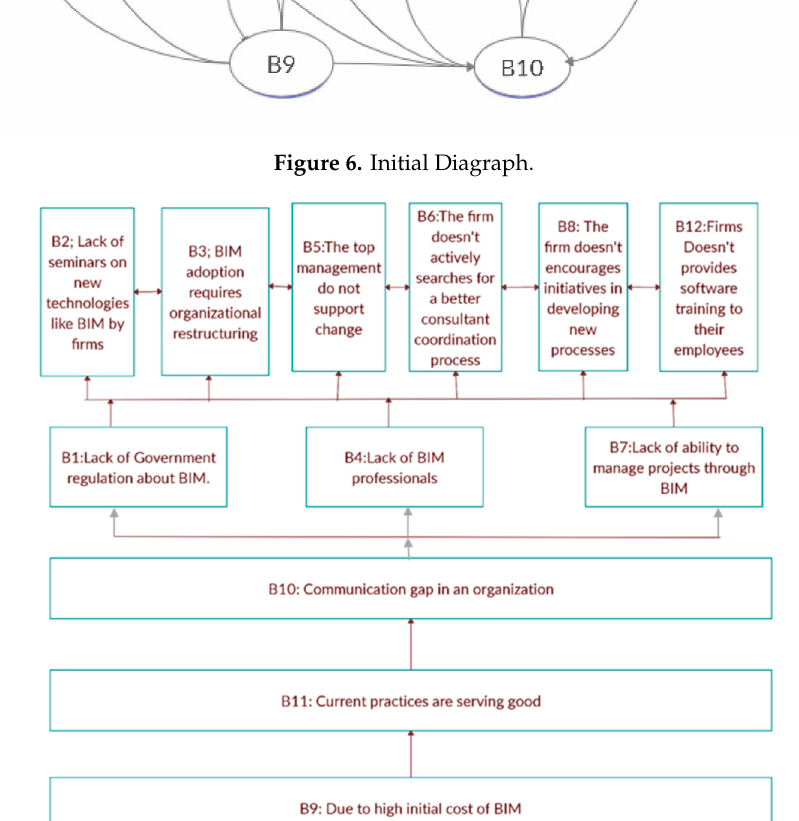
Figure 7. ISM-based hierarchical model for BIM barriers in